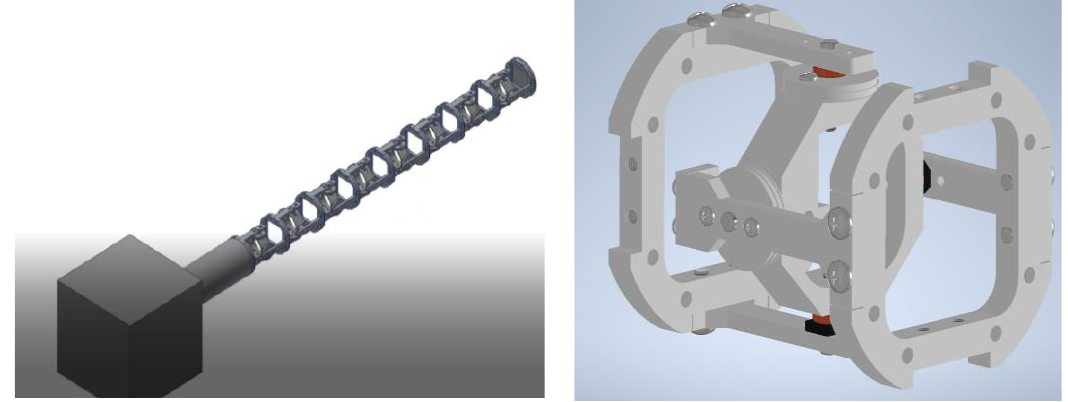
Figure 11. The overall structure of the manipulator ( left ) and the design of the joint ( right ).